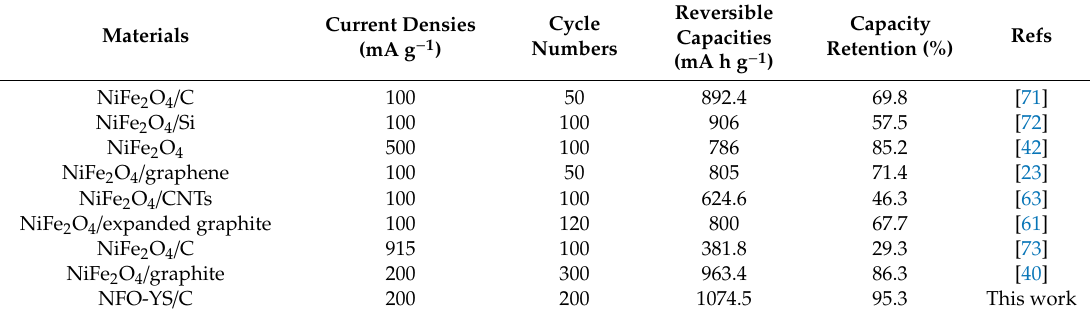
Table 1. The comparison of electrochemical performances delivered by the anode in this work and those in previous